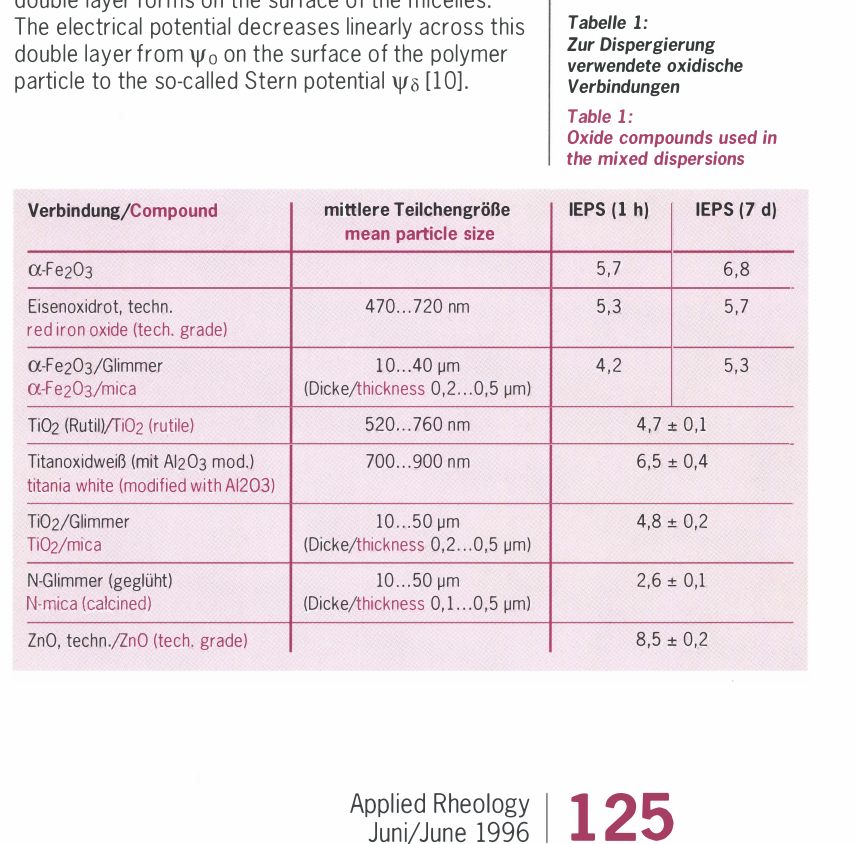
Tabel/e 1: Zur Dispergierung verwendete oxidische Verbindungen Table 1: Oxide compounds used in the mixed